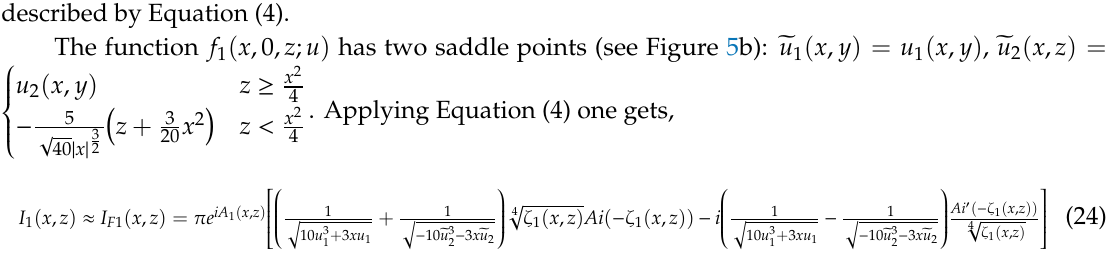
u u u , 2 , 3 , and 4 1 , u 2 , u 3 , and u 4 ) of the functions f